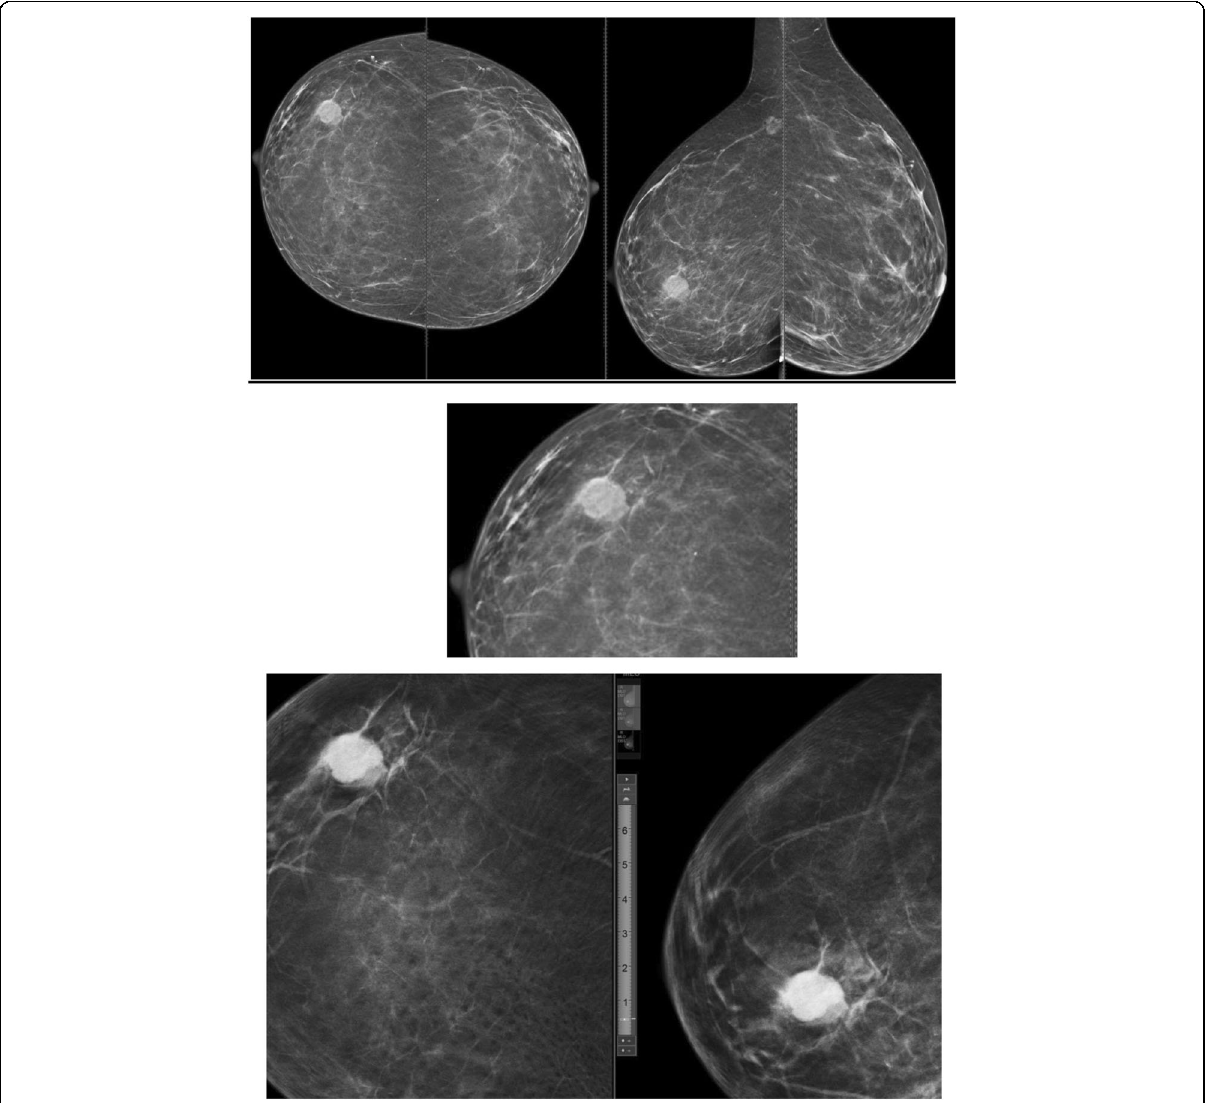
Fig. 8 Fifty-six-year-old female. Mammogram CC and MLO views. Bilateral fatty breasts ACR A. Right LOQ rounded partially well-defined partially obscured dense lesion BIRADS 3. Tomosynthesis of the right breast CC and MLO views. 3D digital breast tomosynthesis showed irregular micro lobulated margin with related architectural distortion of the right LOQ dense mass lesion BIRADS 4. Tomosynthesis detected the fine